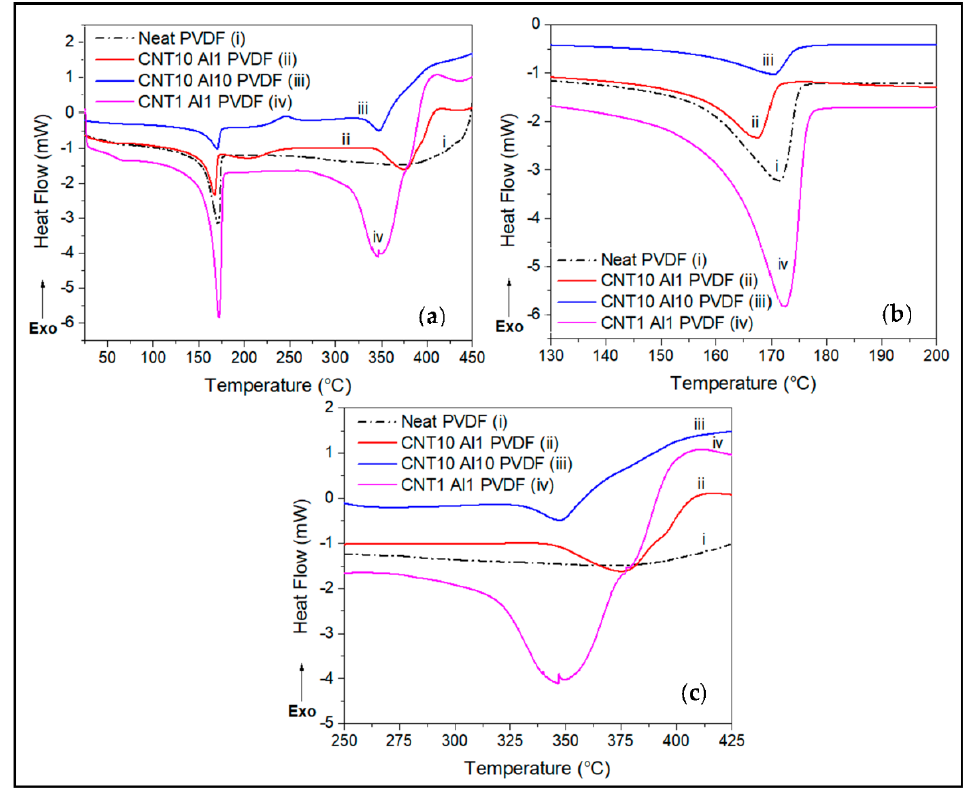
Figure 4. DSC thermograms comparisons of ( a ) effect of combinatorial CNT/Alumina wt.% loadings on PVDF, showing ( b ) endothermic melting peaks between 130 °C and 200 °C, and ( c ) peaks between 250 °C and 425 °C.